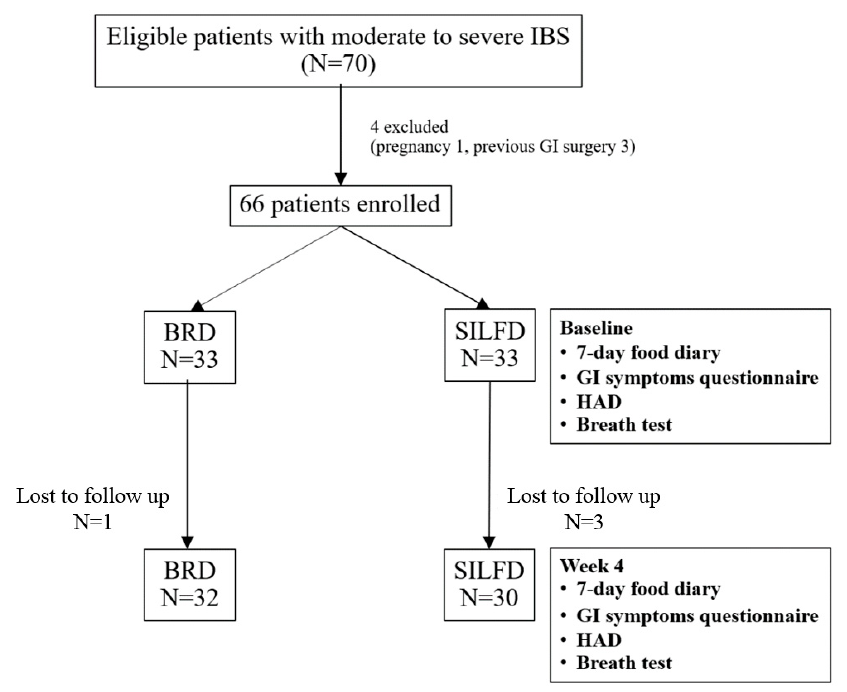
Figure 1. Patient flow during the 4-week study comparing structural individual low-FODMAPs (fermentable oligosaccharides, disaccharides, monosaccharides, and polyols) diet advice (SILFD) and brief advice on a commonly recommended diet (BRD). IBS: irritable bowel syndrome; GI: gastrointestinal; HAD: Hospital Anxiety and Depression scale. Table 1. Baseline characteristics of 62 patients comparing structural individual low-FODMAP diet advice (SILFD) and brief advice on a commonly recommended diet (BRD).